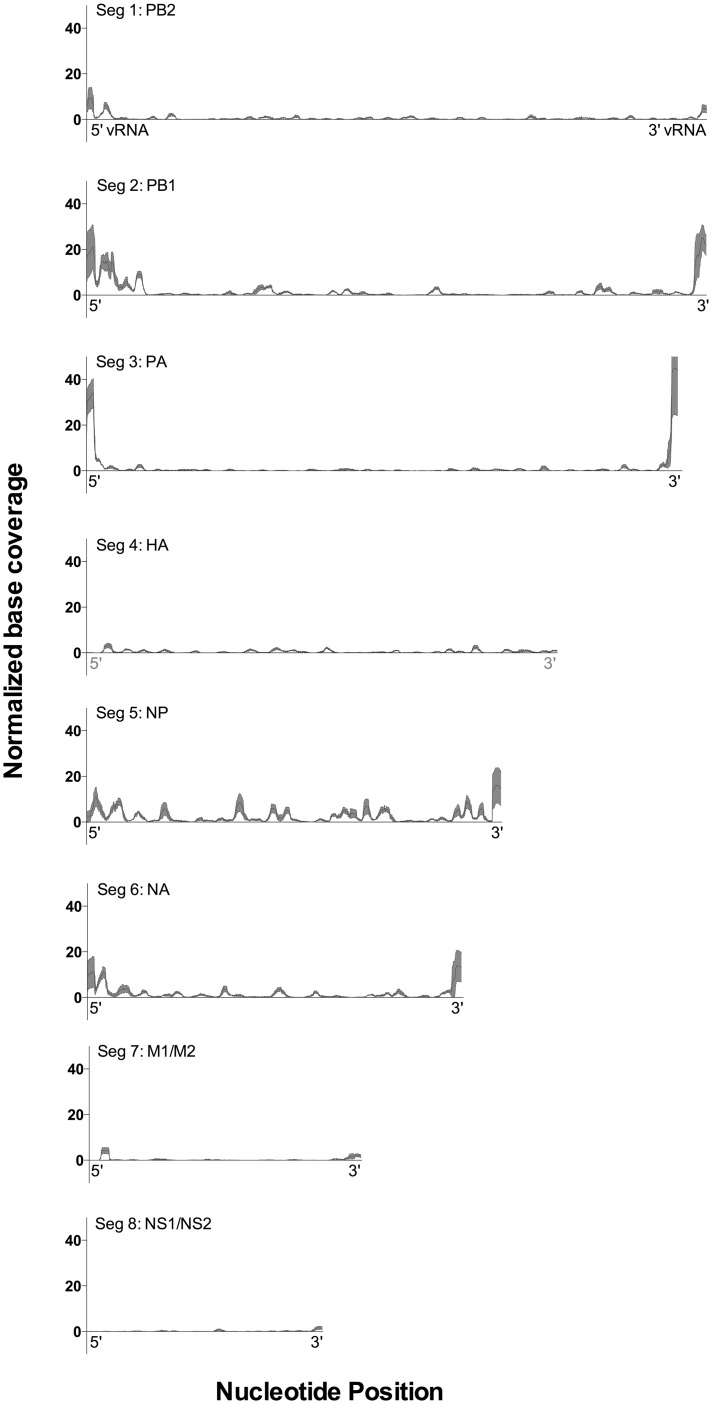
Segment-specific genome coverage of reads mapped to PR8.Influenza virus-specific reads were sorted by genomic coordinate. Strand-specific coverage of each base in the reference sequence was quantified and base coverage values for the seven infected mouse samples were normalized for the total number of PR8-specific reads in the respective sample and displayed as base coverage per thousand reads. For each position in the PR8 genome, the mean and 95% CI of the normalized coverage of the vRNA were calculated and are displayed as black and red, respectively. Nucleotide position is counted from the 5’ end of the vRNA.